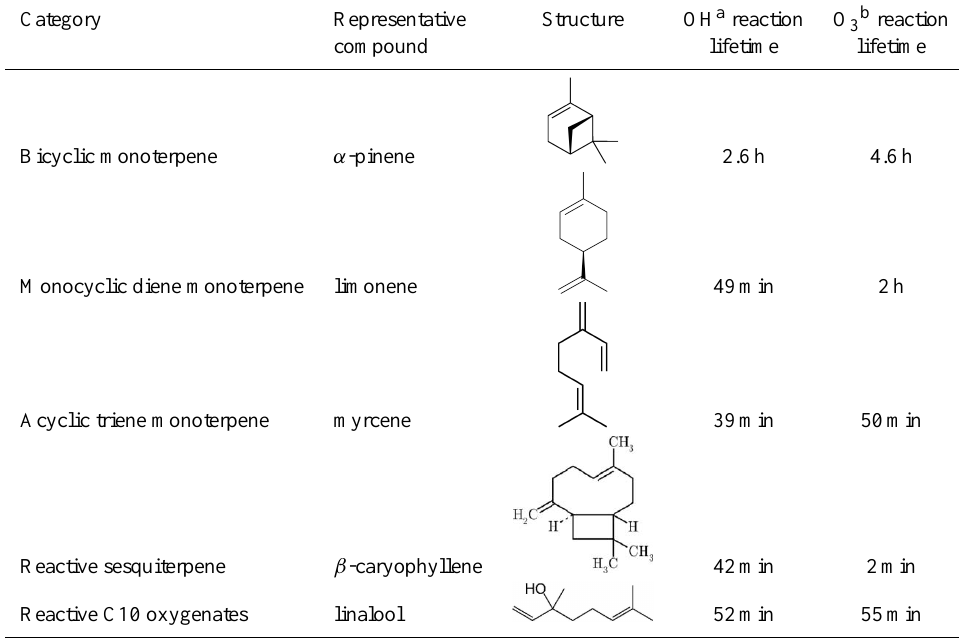
Table 2. List of all five precursors, structures and reactivity towards OH and O 3 based on reaction lifetimes from Atkinson and Arey